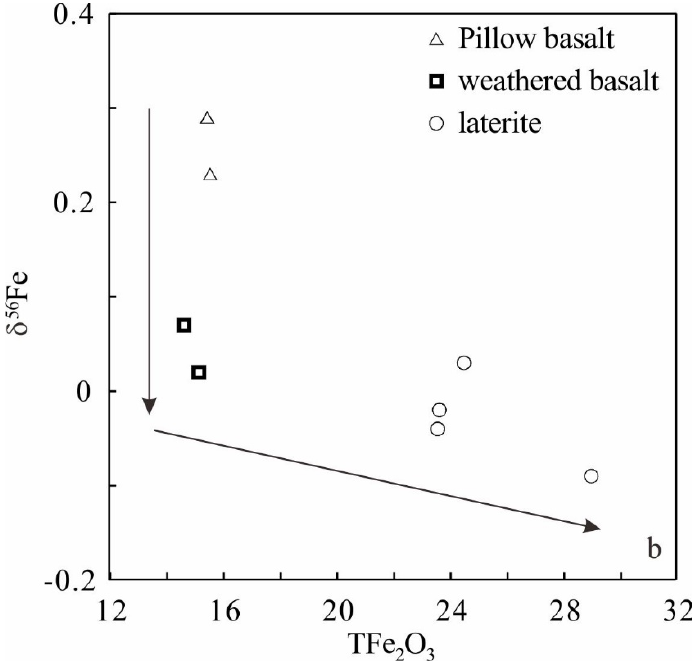
Figure 3. Relationship plot between the Fe isotopic composition of magnetite and the Fe content in the Qinglong Shazi Sc deposit. T stands for total Fe.